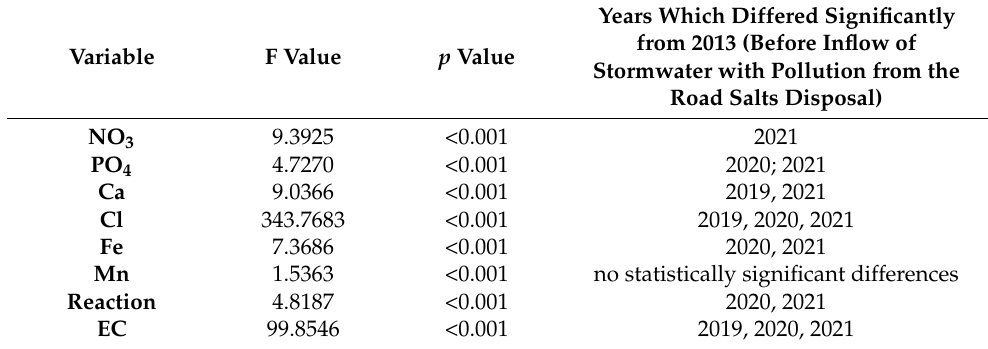
Table 3. Results of one-way ANOVA analyses (with Tukey HSD) for the investigated variables in Lake Mielenko ( n = 384).